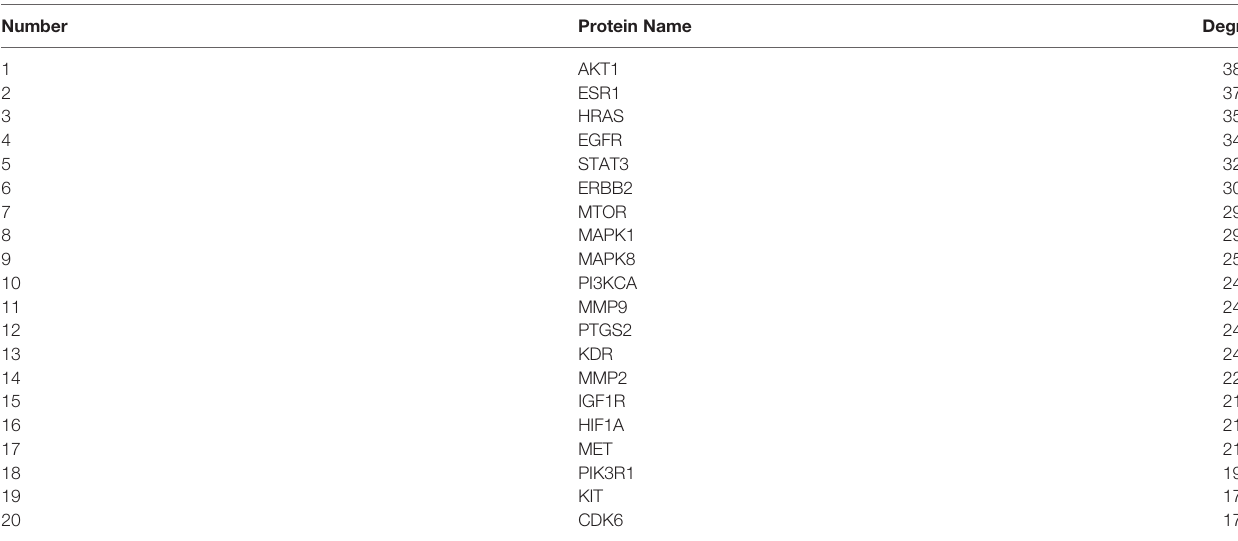
TABLE 2 | Key targets of STF decoction in the treatment of GC.